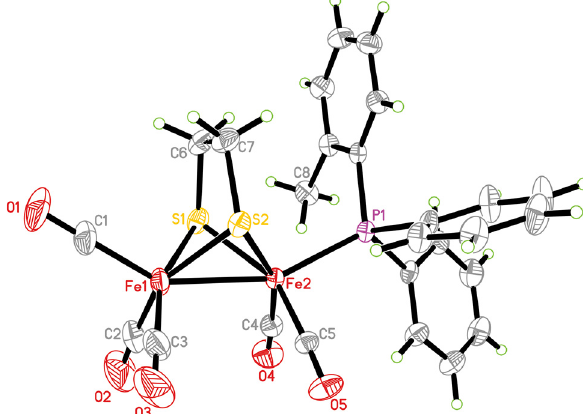
Table  : Data collection and